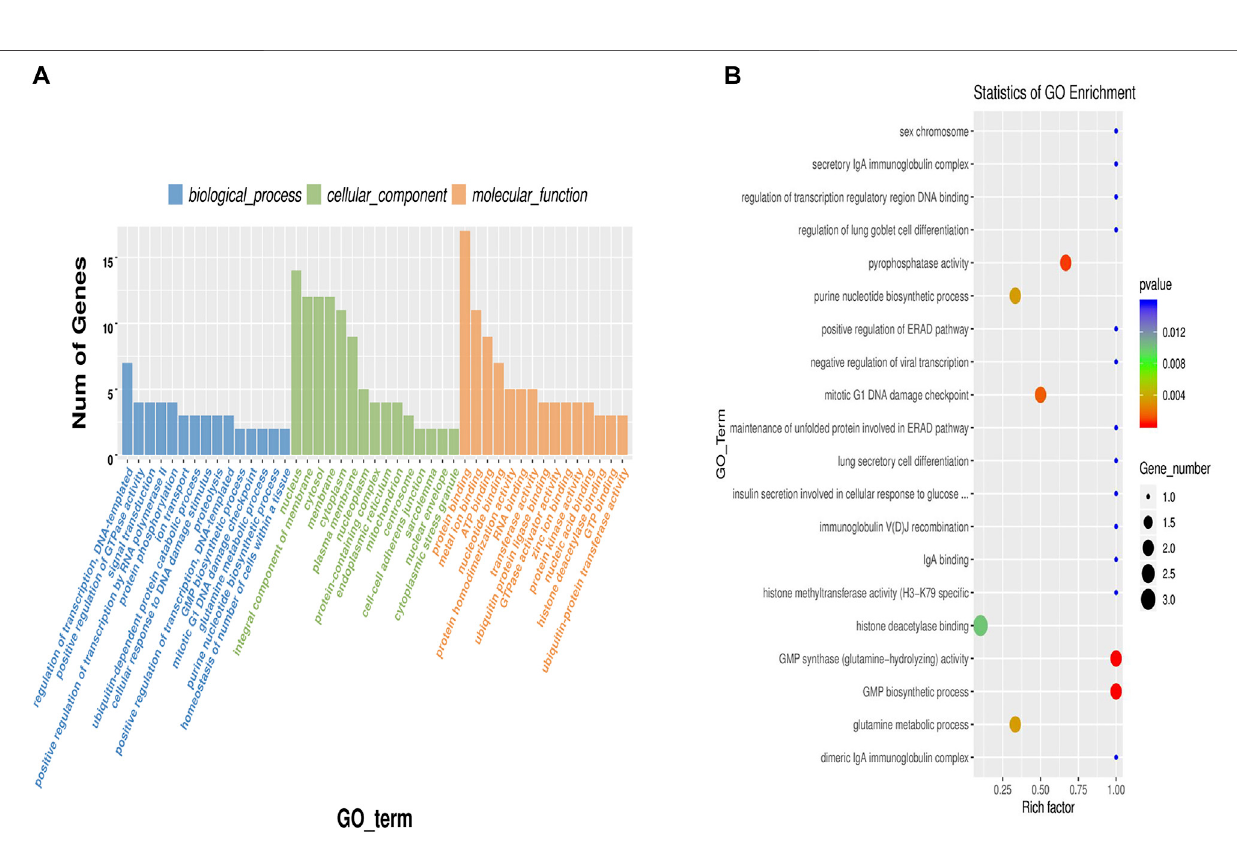
Frontiers in Genetics |